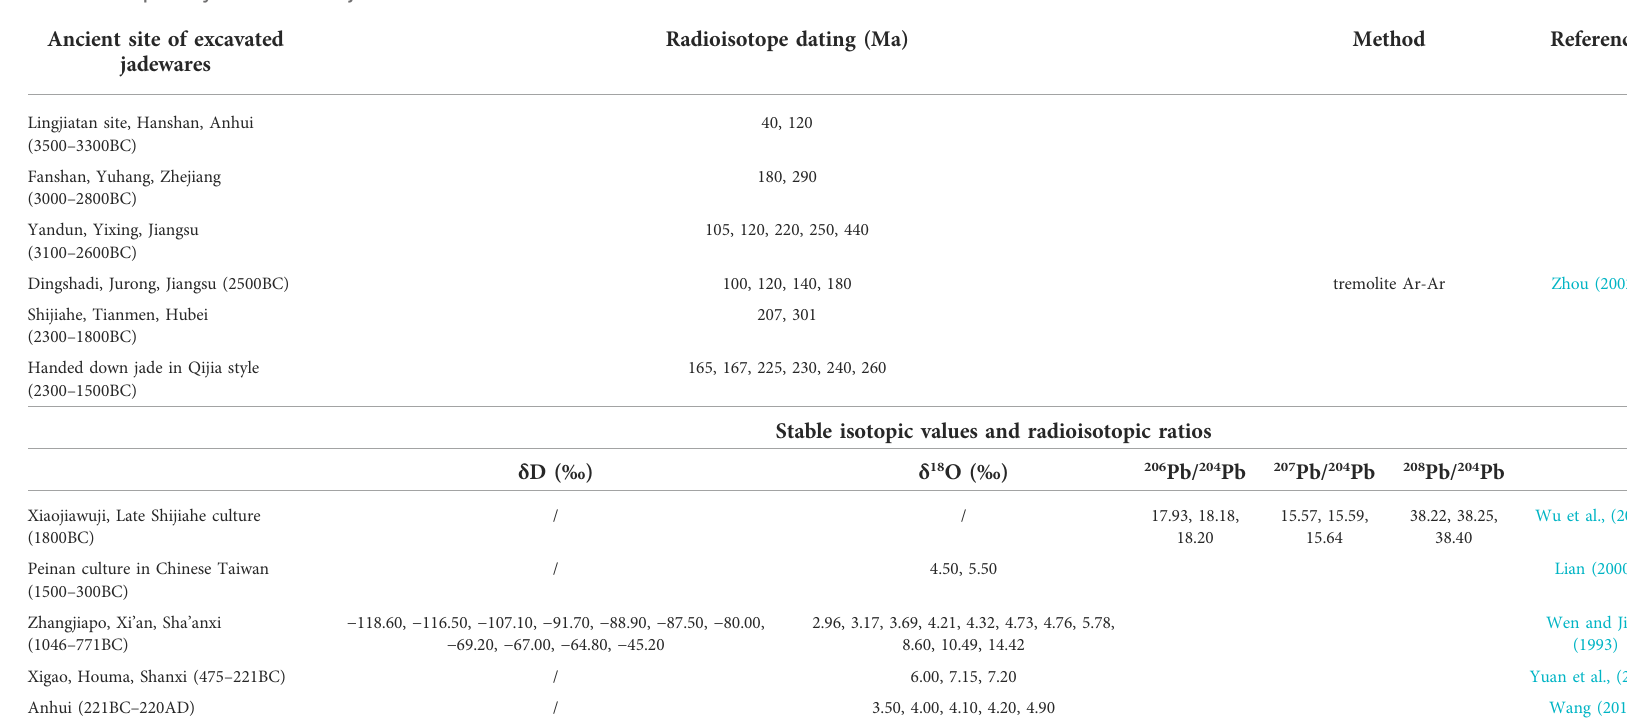
TABLE 4 Isotope analysis of excavated